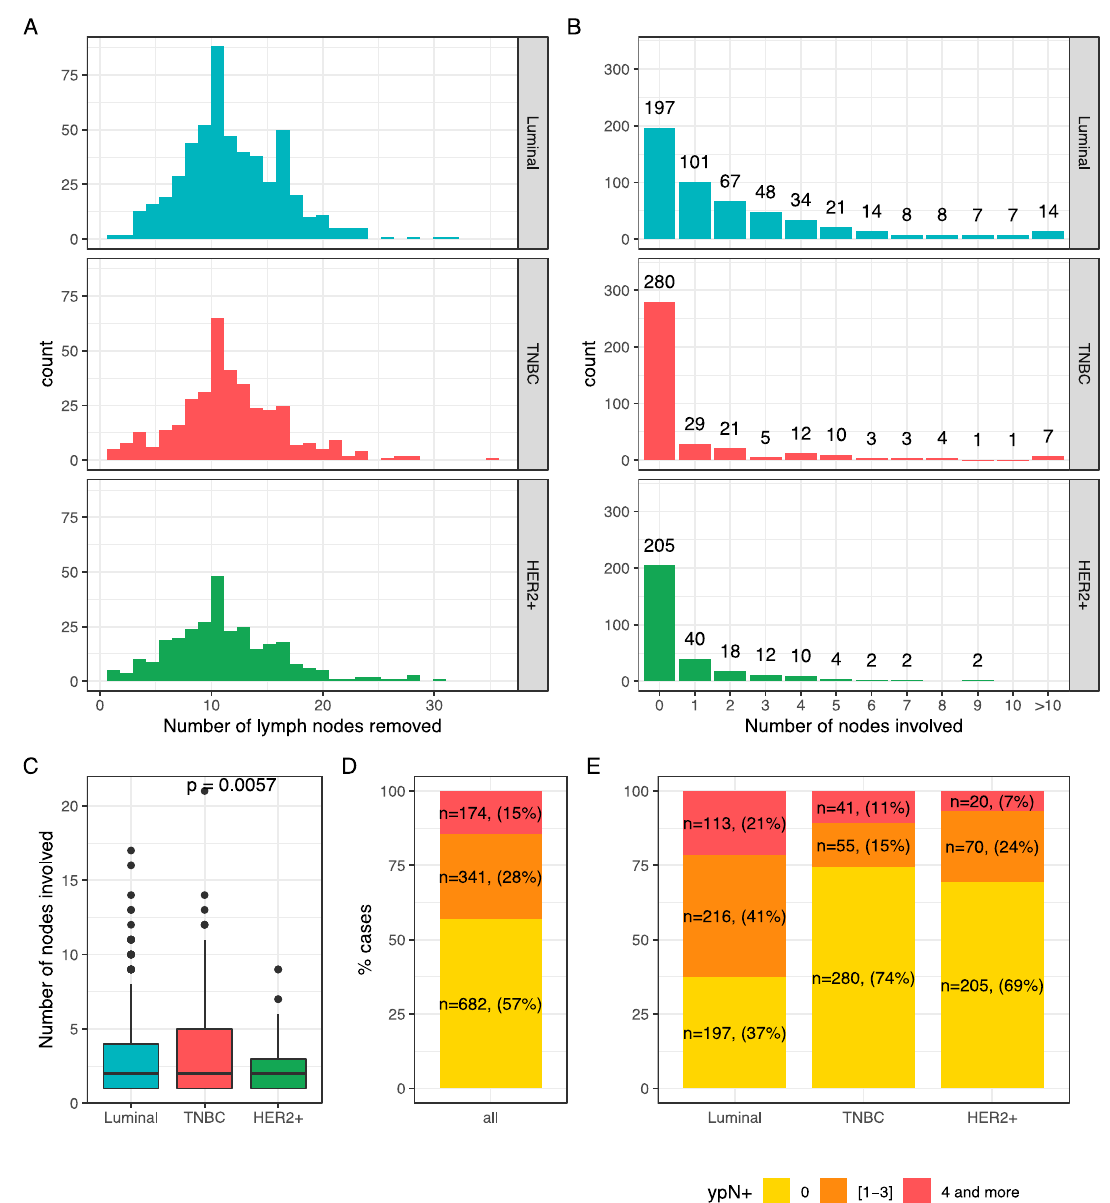
Figure 1. Nodal burden after NAC: number of lymph nodes removed according to BC subtype ( A ); number of involved nodes according to BC subtype ( B ); mean number of nodes involved after NAC according to BC subtype ( C ); node involvement repartition after NAC in the whole population ( D ) and according to BC subtype ( E ).